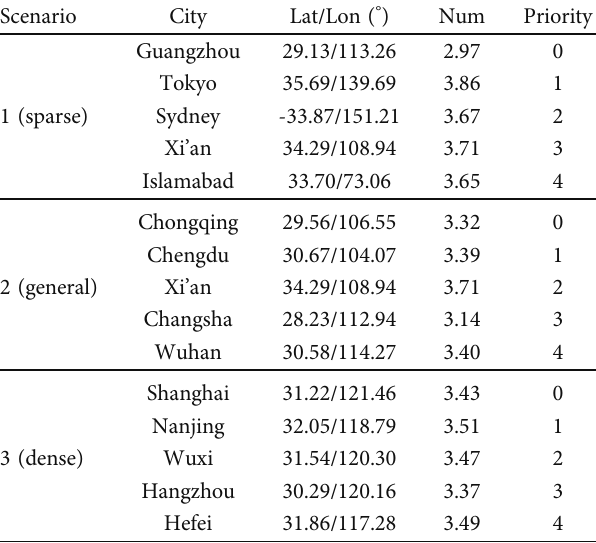
Table 2: The parameters of cities.